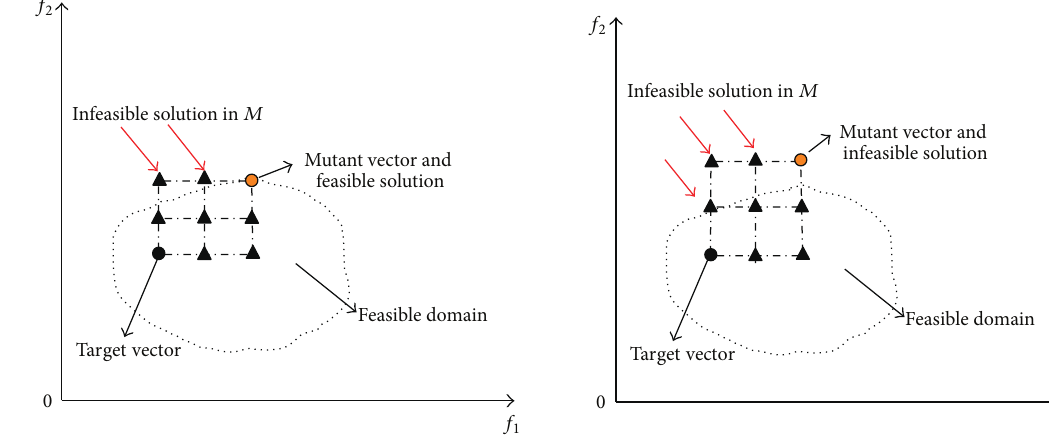
Figure 1: Infeasible solutions obtained by QOX in the two-dimensional search